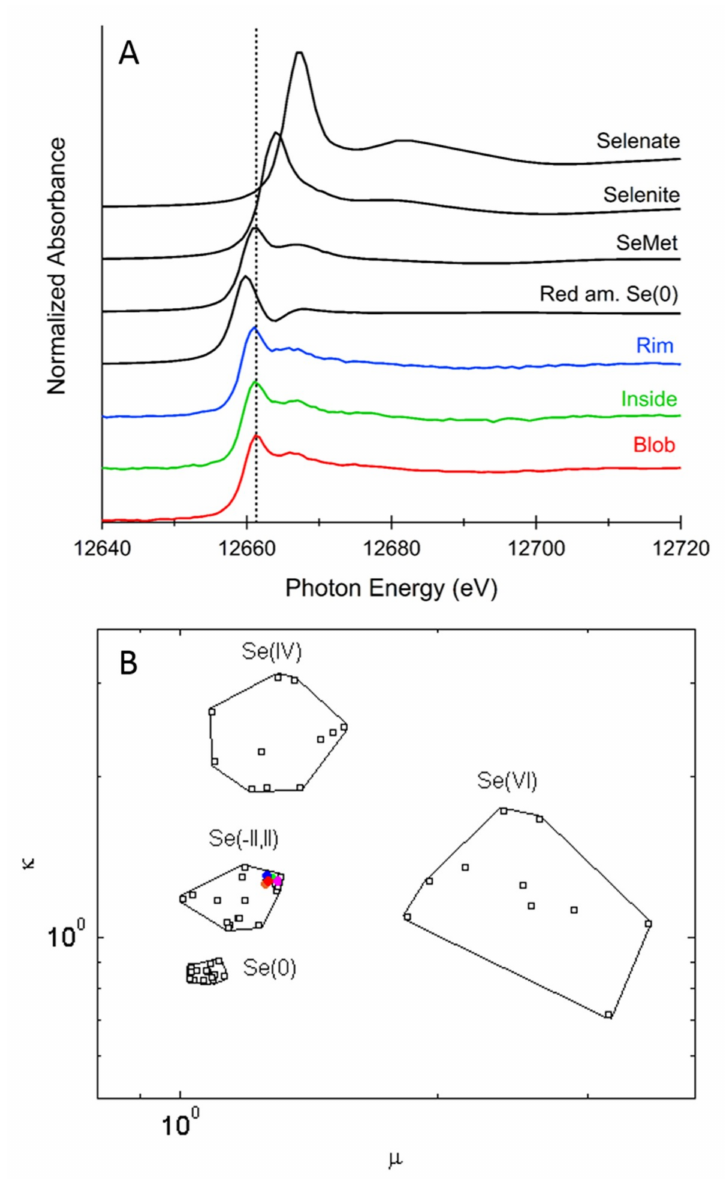
Figure 3. ( A ) Se K-edge micro X-ray absorption near-edge structure spectra of Brazil nut at locations shown in Figure 2A. The “Blob” (red graph) is the average spectrum of spots 0, 1 and 3, the “Inside” (green graph) is the average spectrum of spots 6 and 7 and the “Rim” (blue graph) is the average spectrum of spots 9 and 10. Spectra of selected standard compounds are shown in black for comparison. ( B ) Se valence scatter plot of the Brazil nut X-ray absorption near-edge structure data (same color as in panel A), plus spot 4 is in magenta and spot 2 is in orange. Se standard compounds are shown as open black